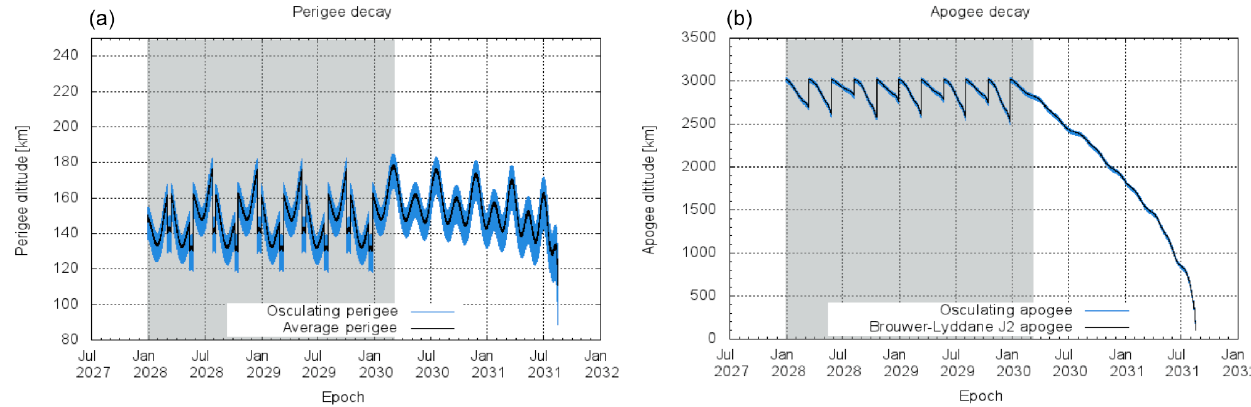
Figure 9. Daedalus perigee (a) and apogee (b) history for a spacecraft launch in 2028, initial apogee at 3000km and initial satellite mass of 450kg (including propellant). Apogee and perigee maintenance is employed by means of propulsion.